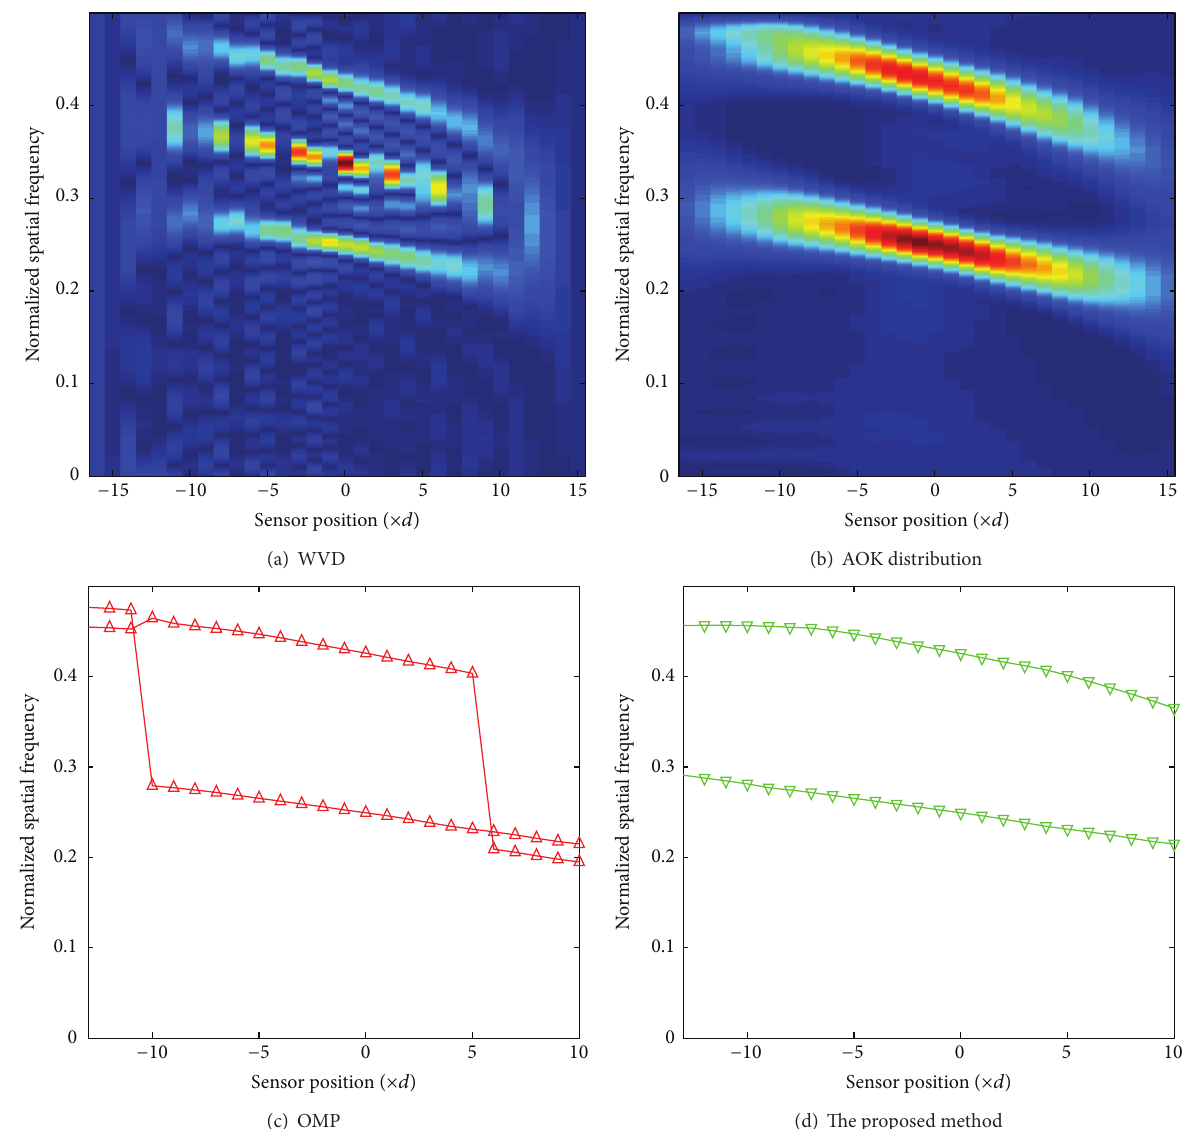
Figure 10: Near-field source location estimation using the ULA ( 𝑟 1 = 300 m, 𝜃 1 = 30 ∘ and 𝑟 2 = 1000 m, 𝜃 2 = 60 ∘